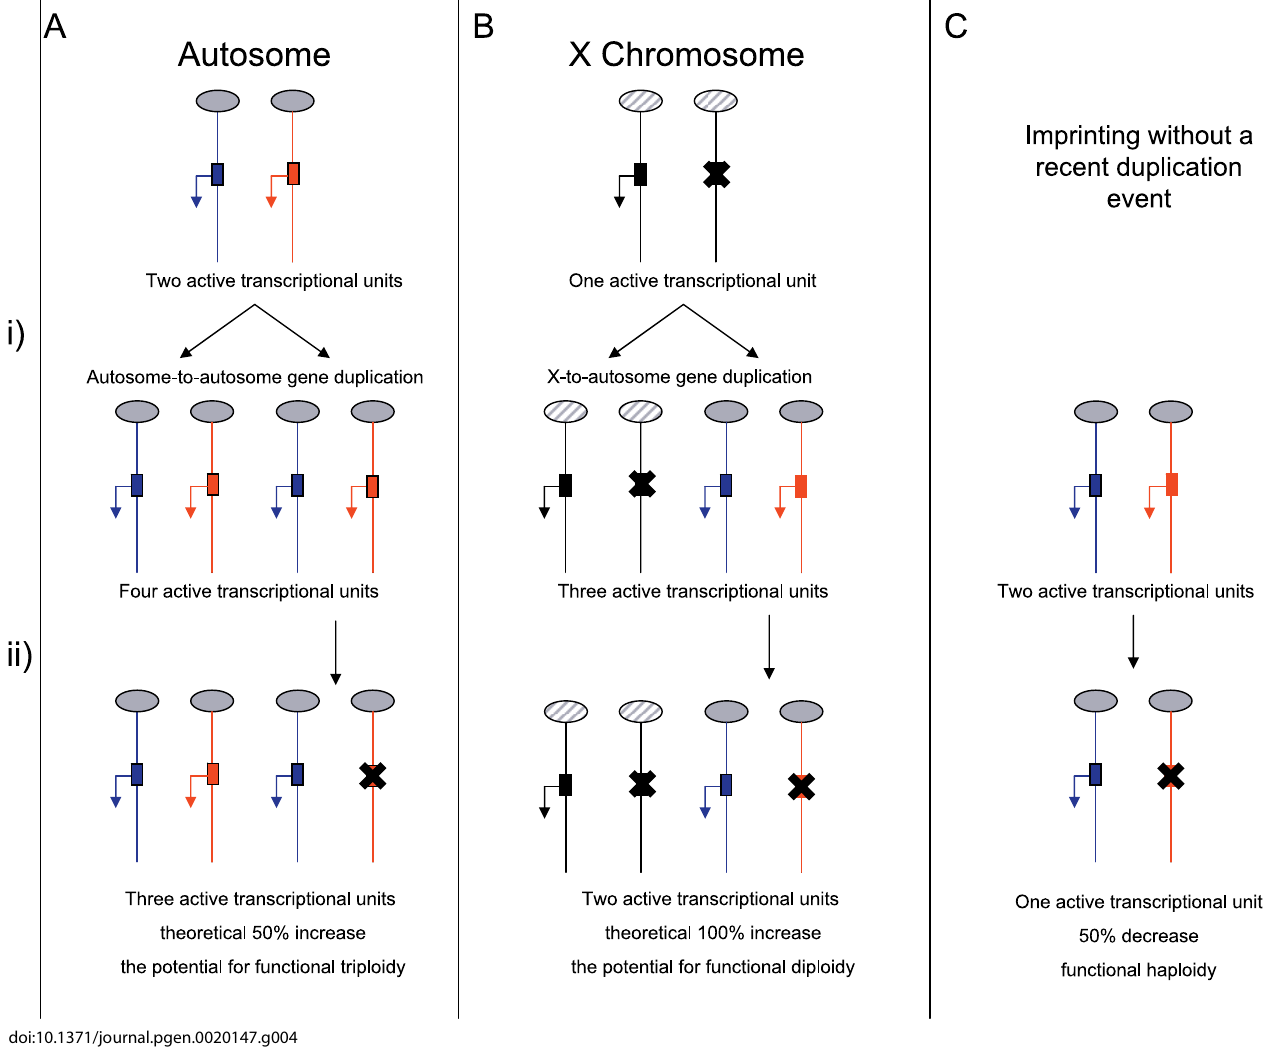
Figure 4. Possible Gene Dosage Scenarios before and after the Acquisition of Imprinting For the two duplication scenarios (A and B), imprinting of the duplicated locus is presumed to arise while functional redundancy exists with the original copy. For simplicity, each example refers to a paternally expressed imprinted gene. Grey ovals represent autosomes, hatched ovals represent the X chromosome, red represents maternally derived chromosomes and alleles, and blue represents paternally derived chromosomes and alleles. (A) A nonimprinted autosomal gene undergoes duplication (i), resulting in a 2-fold (2:4) increase in active gene copy number. Imprinting (ii) reduces this increase to 1.5-fold (2:3). An example is the Mkrn3 gene on mouse Chromosome 7 [118]. (B) A gene subject to X-inactivation undergoes trans -duplication, resulting in a 3-fold (1:3) increase in active gene copy number. Imprinting reduces this increase to 2-fold (1:2). An example is the U2af1-rs1 locus [58]. (C) A nonimprinted autosomal gene acquires imprinting without undergoing a recent duplication, resulting in a 50% decrease in active gene copy number (2:1). This is likely to be the most common scenario, an example being the Igf2 locus [95].